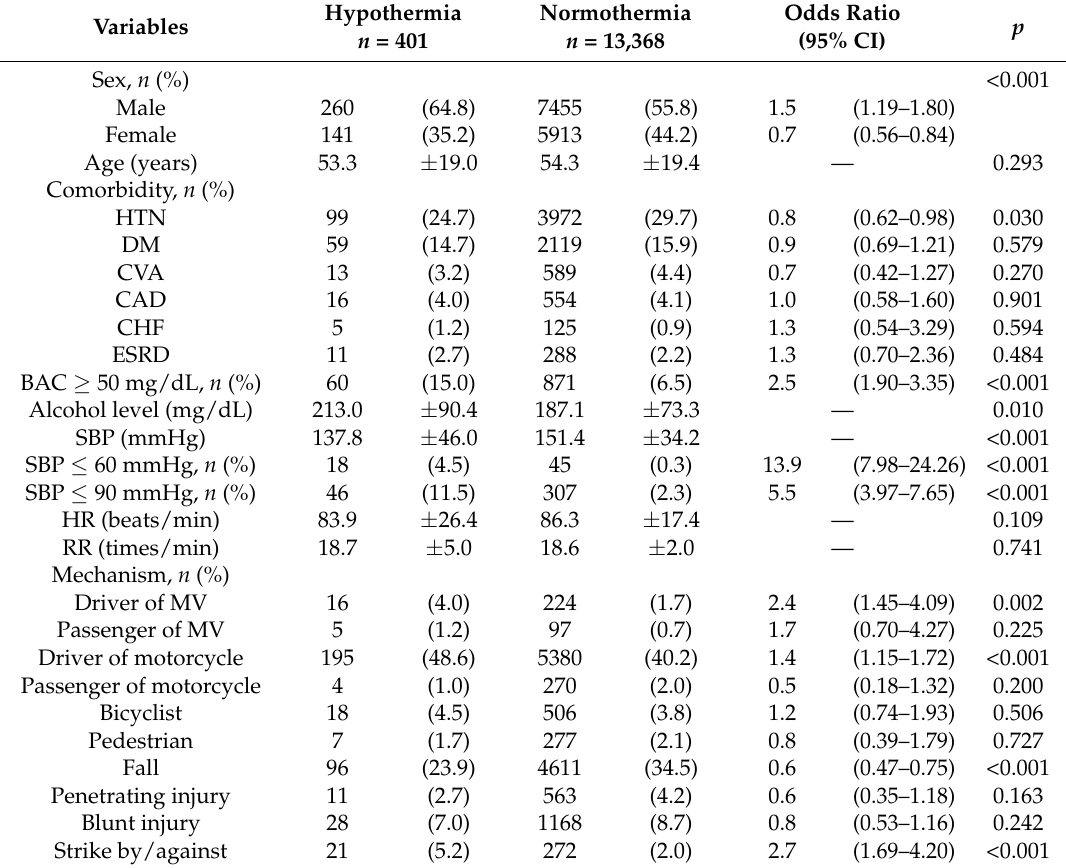
Figure 1. Flowchart of patient selection from the Trauma Registry System. Table 1. Demographics and admission characteristics of the study groups.